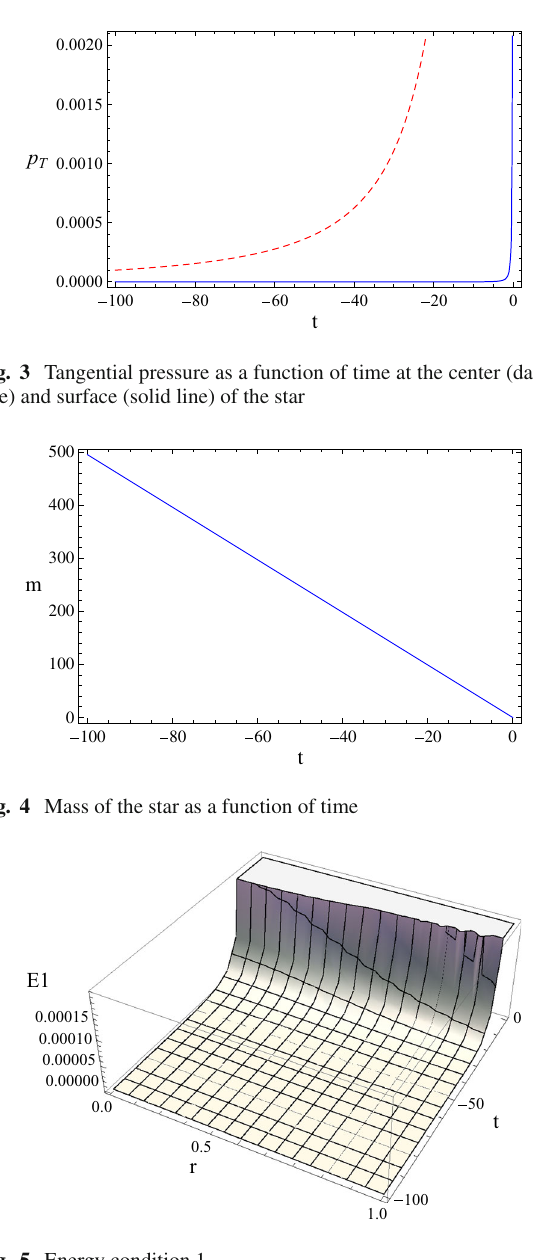
Fig. 5 Energy condition 1